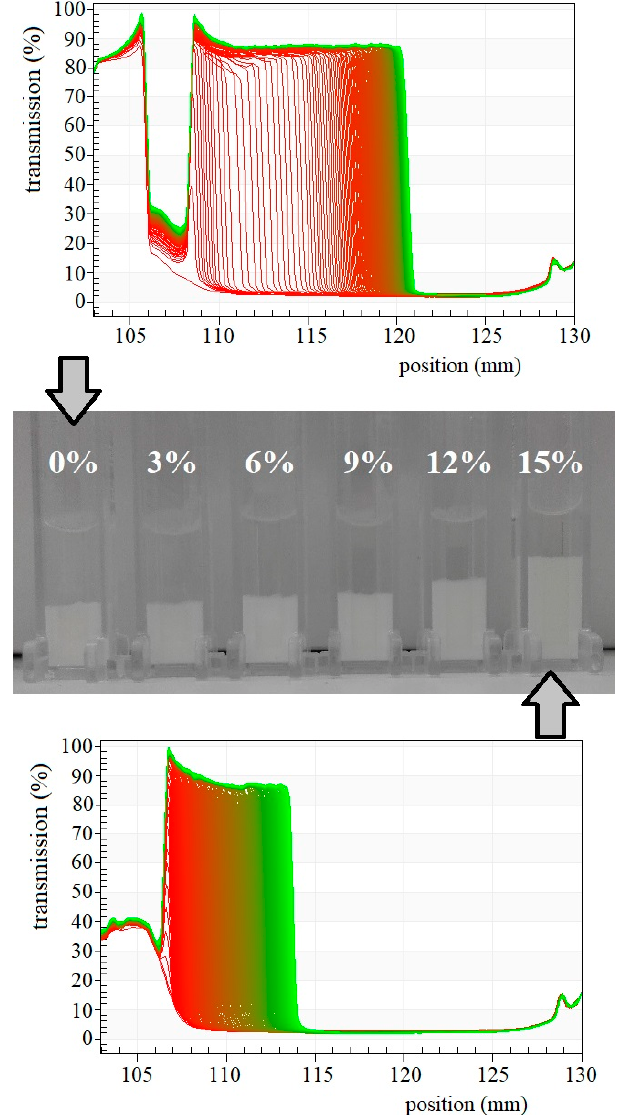
Figure 10. Transmission profiles (“fingerprints”) on the example of yogurts containing 0% or 15% w / w inulin addition—the LUMiSizer test.